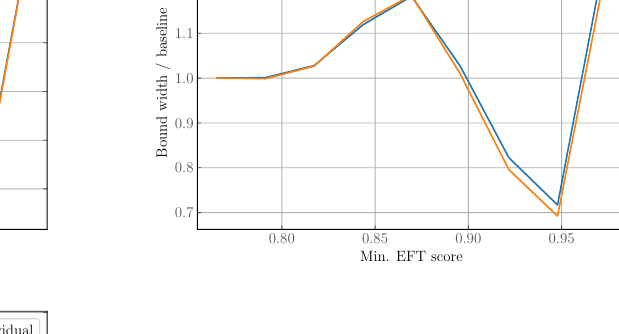
Figure 7 . Representative relative improve- ment (decrease in the 2 σ Wilson coefficient interval) over the individual (orange) and pro- filed (blue) operator constraints quoted in ta- ble 3 by imposing cuts on the ML score.